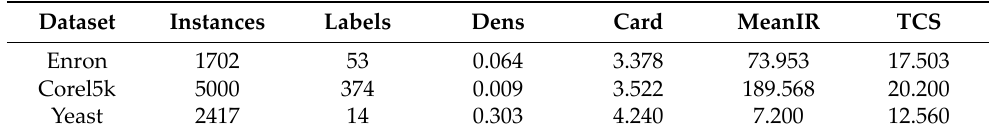
Table 1. Description of the three benchmarking